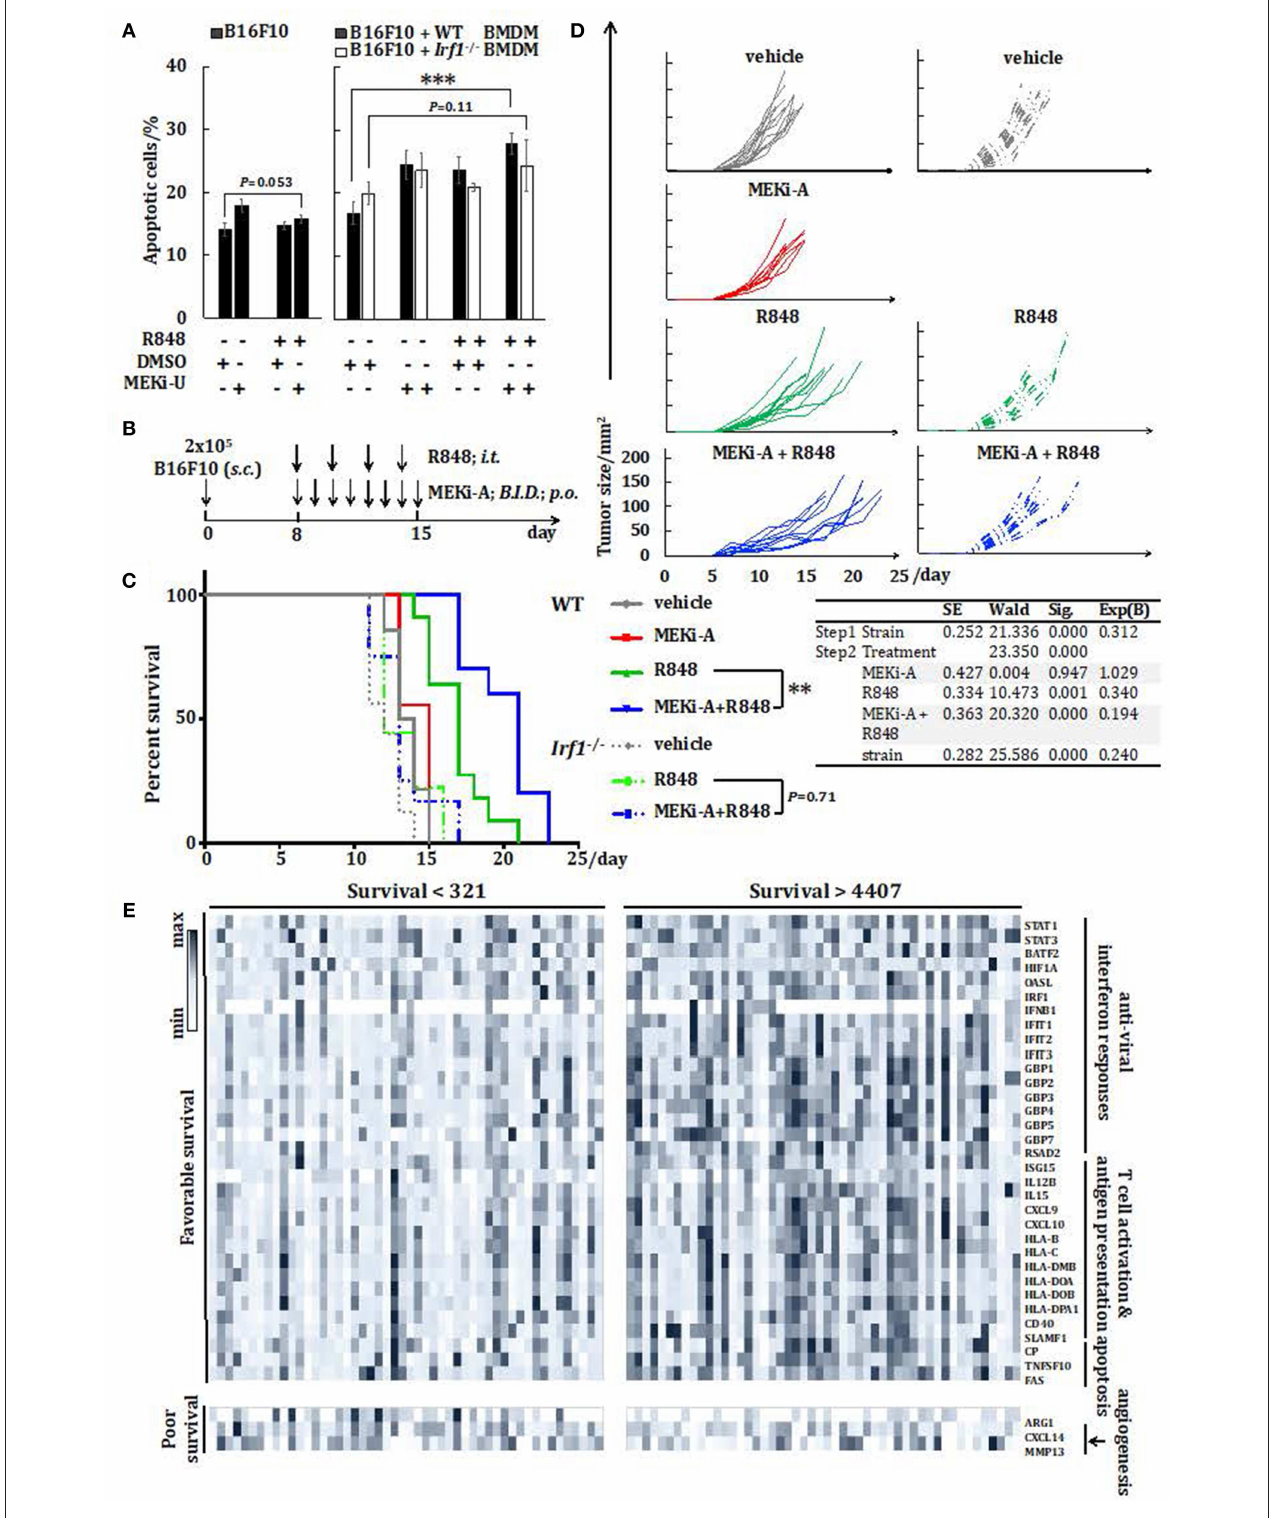
FIGURE 7 | Combination therapy with MEK1/2 inhibitor and TLR7 agonist reduces melanoma progression in vivo. (A) Flow cytometry analysis of B16F10 apoptosis cultured alone or co-cultured with WT or Irf1 − / − BMDM. Cells were stimulated with R848 in the presence or absence of MEKi-U for 48h. Data are means ± SD